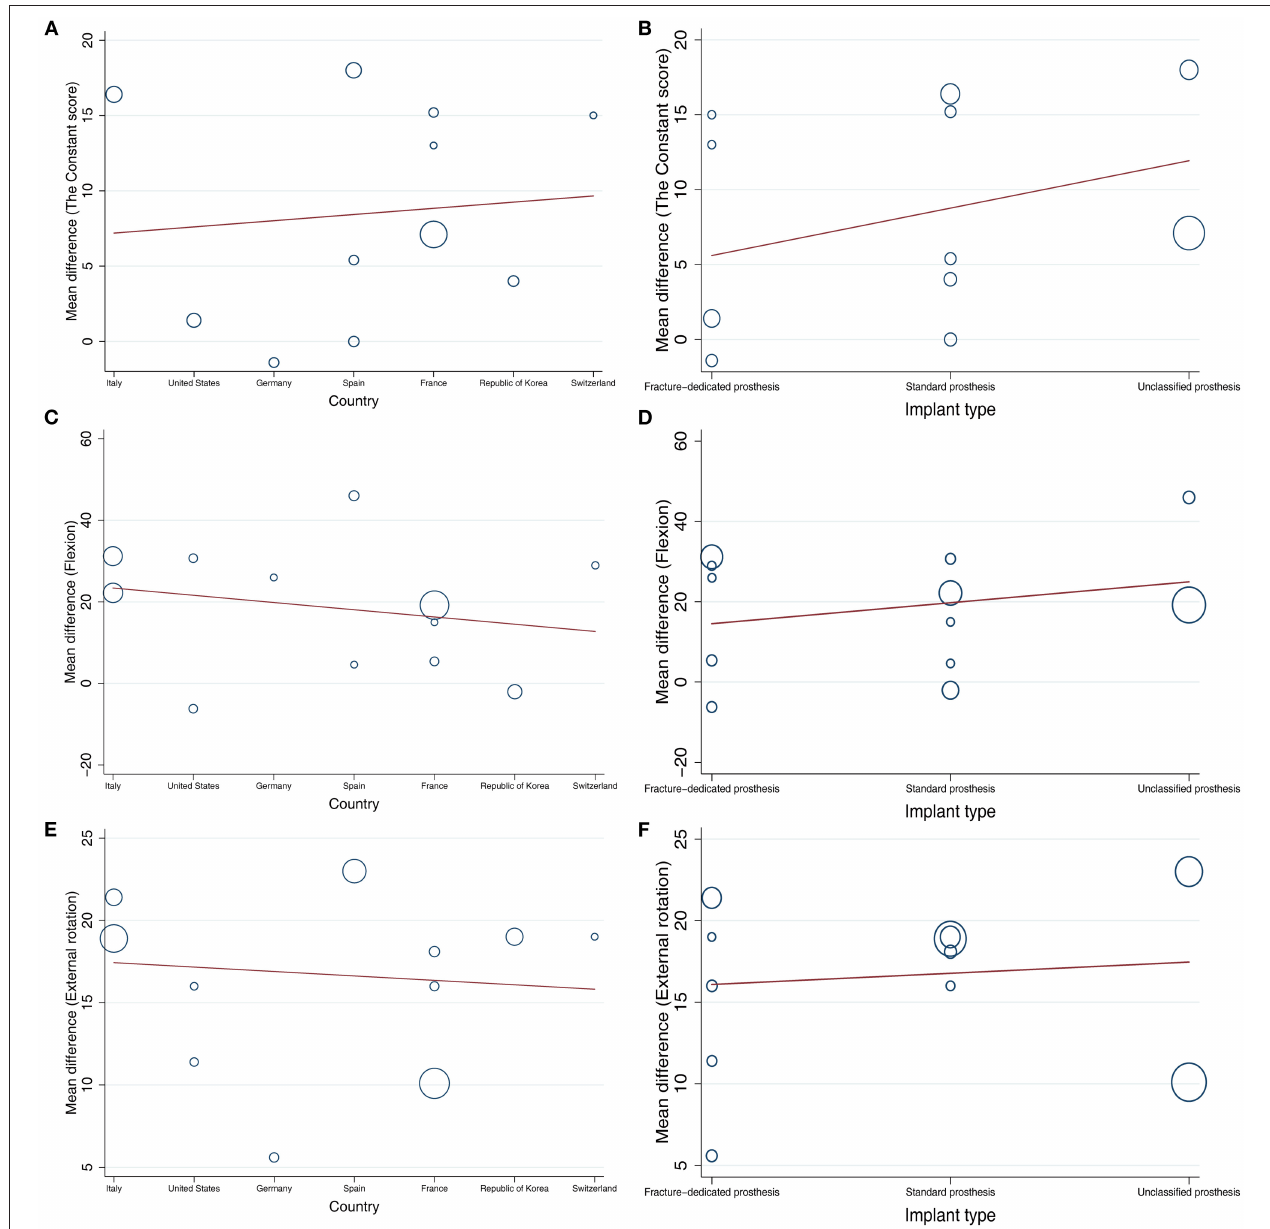
FIGURE 4 | Meta-regression analysis between country or the design of prosthesis and the Constant score, flexion, or external rotation. (A) : analysis between country and the Constant score, (B) : analysis between the design of prosthesis and the Constant score, (C) : analysis between country and flexion, (D) : analysis between the design of prosthesis and flexion, (E) : analysis between country and external rotation, (F) : analysis between the design of prosthesis and external